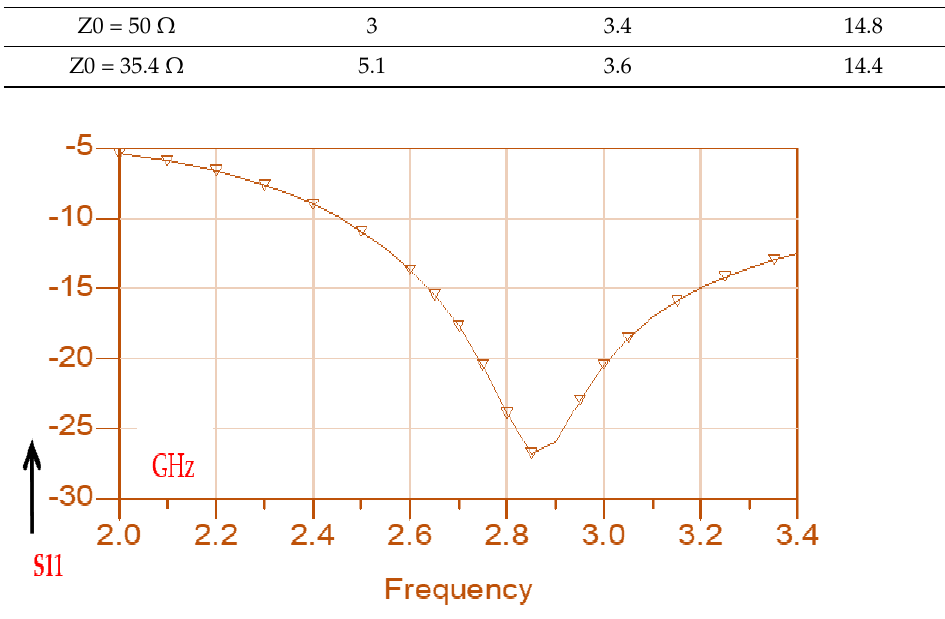
Figure 4. Layout of the −3 dB branch line coupler.